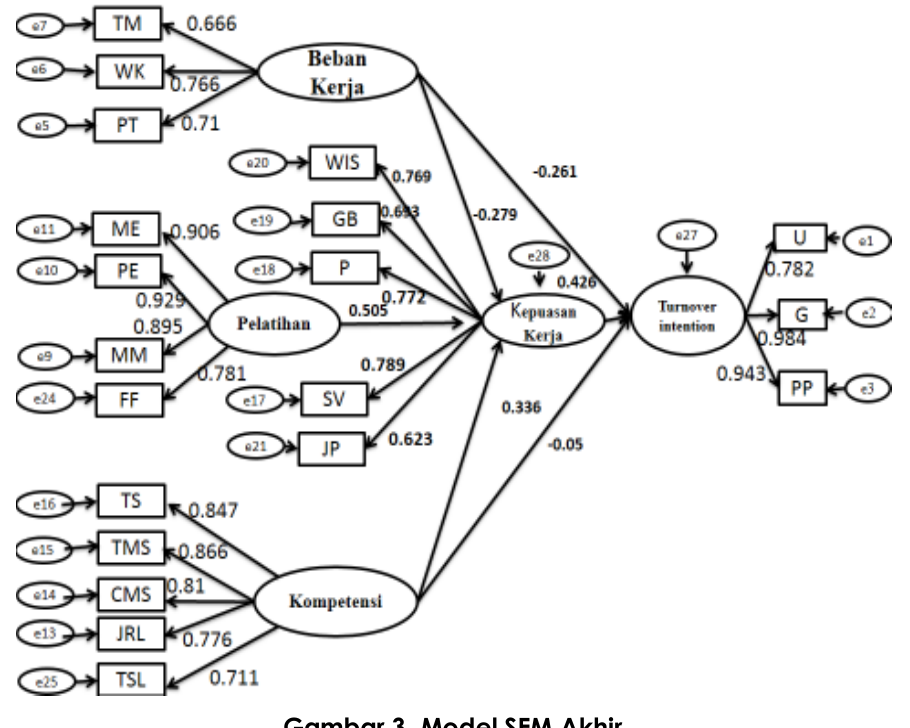
Gambar 3. Model SEM